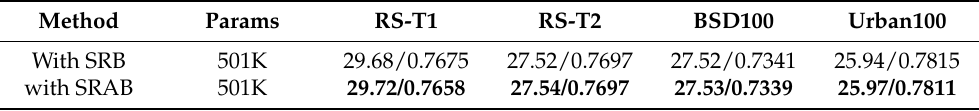
Table 3. Results of our model on four test sets after using SRAB and SRB,